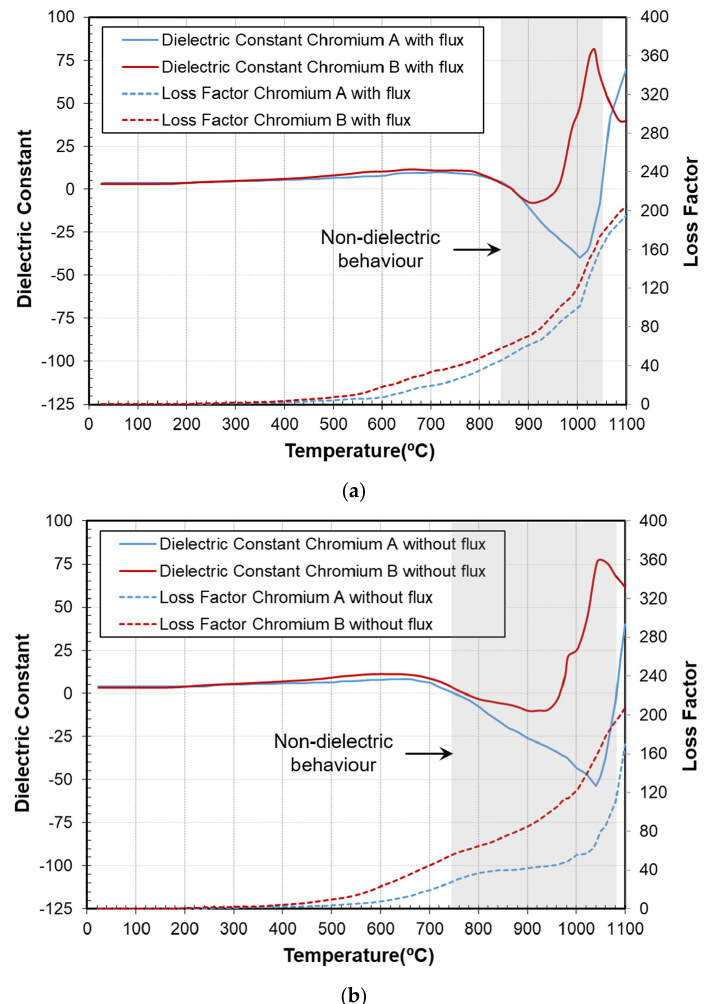
Figure 6. Permittivity measurements of the samples during the microwave synthesis of the pigment: ( a ) raw material mixture including flux (boron oxide) and with different types of chromium; ( b ) raw material mixture without fl ux and with di ff erent types of chromium.